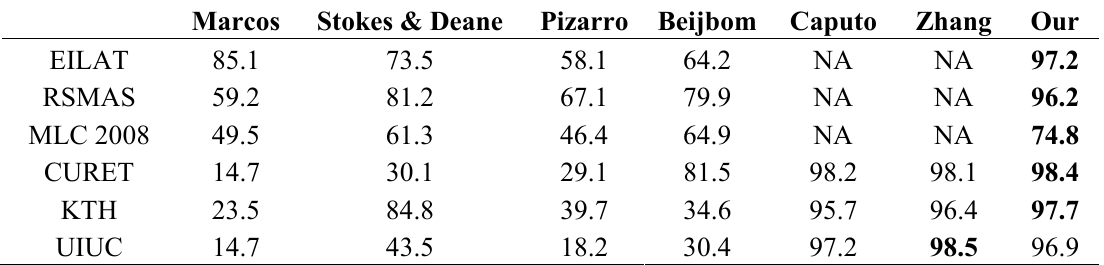
Table 12. Average precision (%) for each method/dataset. The highest average precision for each dataset is shown in bold. NA represents not